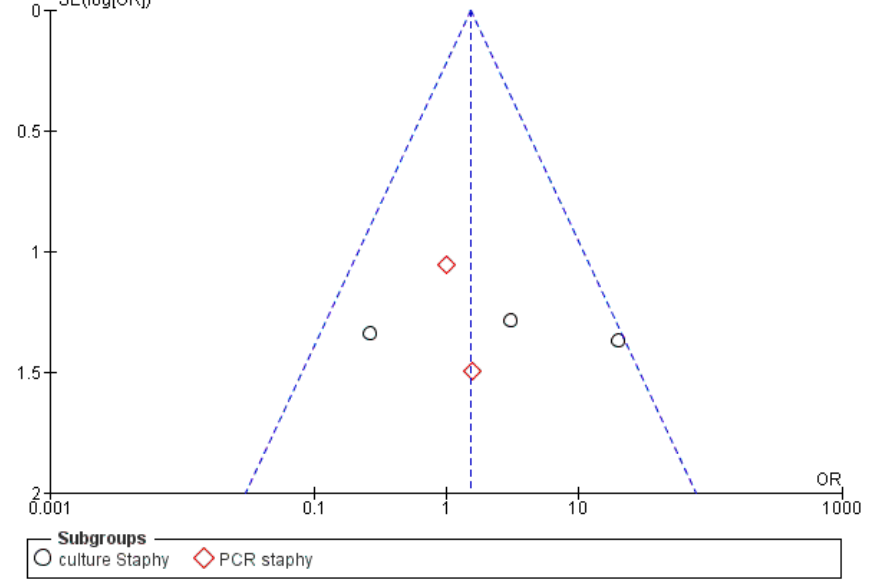
Figure 5. Funnel plot for the sub-group Staphylococcus, I 2 = 30%. Sub-group culture I 2 = 62%. Sub-group PCR I 2 = 0%. The heterogeneity between the two sub-groups is I 2 = 0%.